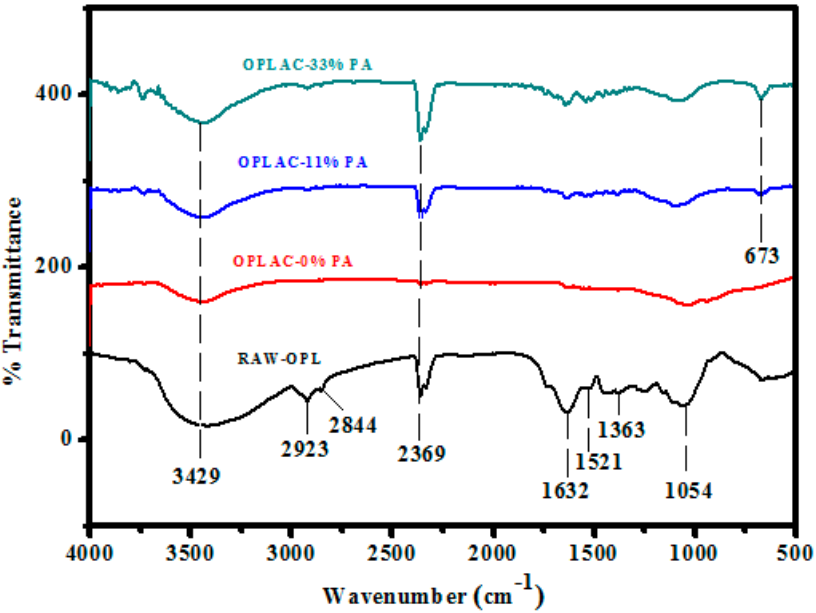
Figure 8. Fourier-transform infrared (FTIR) spectra of OPL-derived activated carbon, impregnated with different concentrations of phosphoric acid.